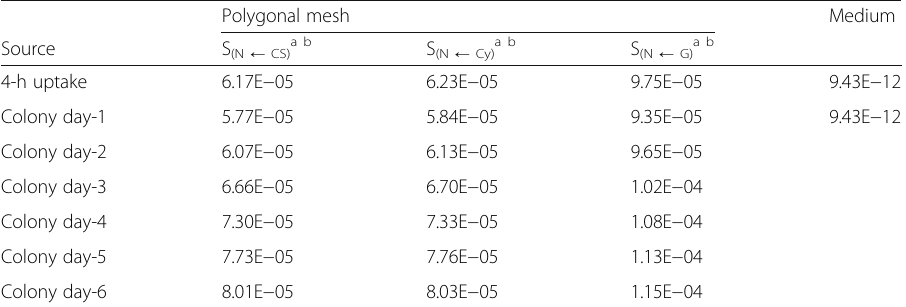
Table 4 S values calculated for the 4-h uptake (cellular distance of 1 diameter) and the 6-day colony forming (from single cells to clusters of increasing size) for polygonal mesh models and localization of the internalized source in cytoplasm or Golgi Polygonal mesh Medium